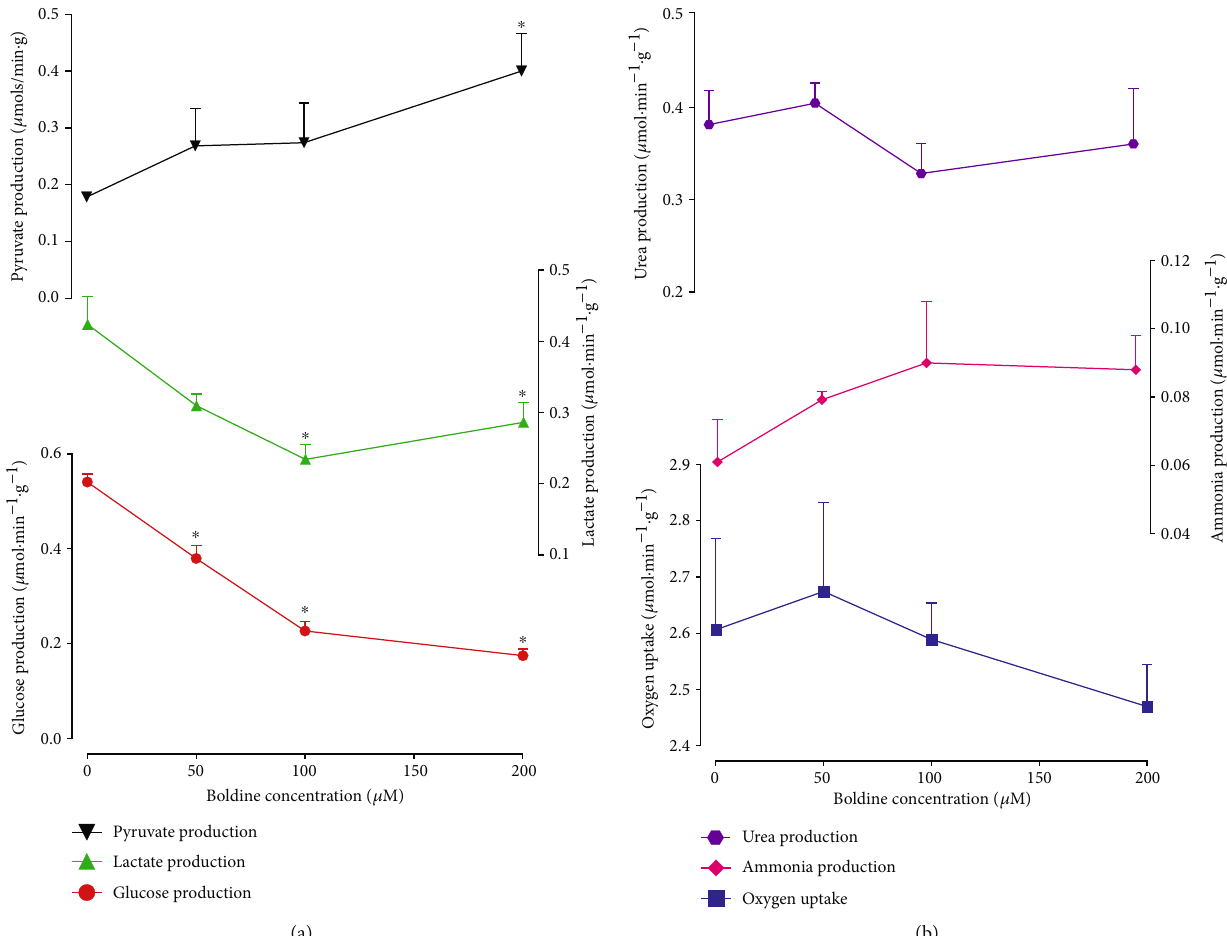
Figure 6: Concentration dependence of the e ff ects of boldine on alanine gluconeogenesis in the perfused livers from fasted rats. Livers were perfused as described in the Materials and Methods. The metabolic rates were calculated at 36 minutes of perfusion time (control condition, zero boldine concentration; n = 12 ) and at 5 minutes of perfusion time ( n = 4 ). Asterisks ( ∗ ) indicate statistically signi fi cant di ff erences when compared to the control condition (absence of boldine), as indicated by post hoc testing according to Student-Newman-Keuls ( p ≤ 0 : 05